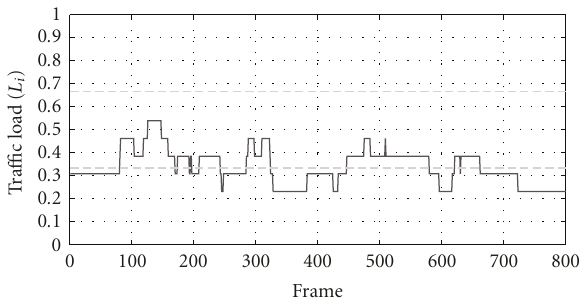
Figure 20: Average tra ffi c load at every second in a real sequence.